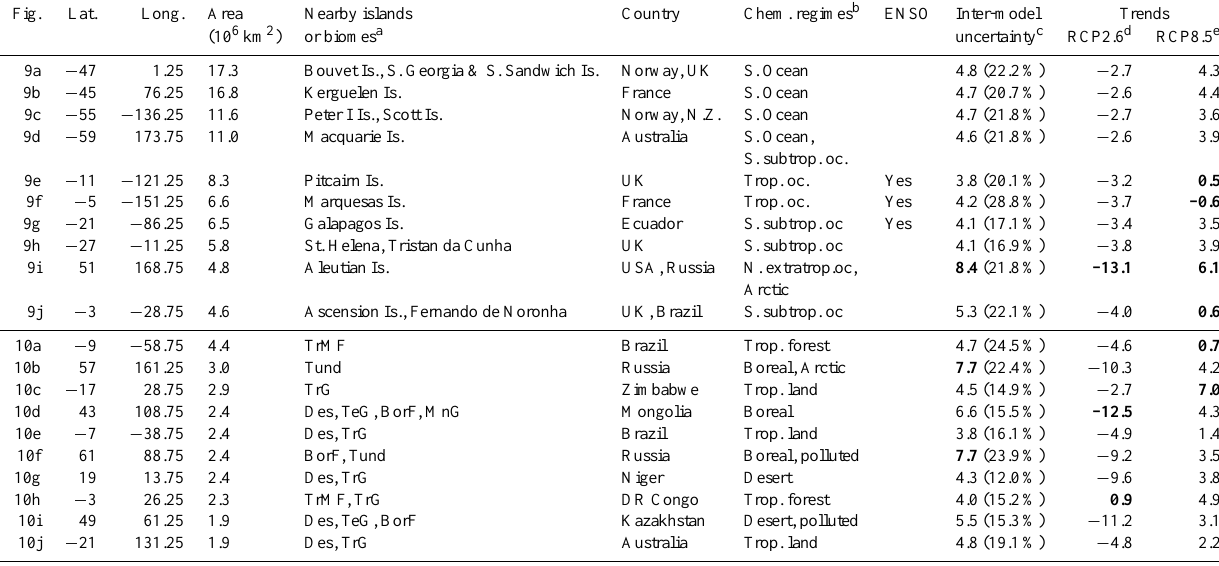
Table 1. Summary of potential ozone sites. Fig. Lat. Long.